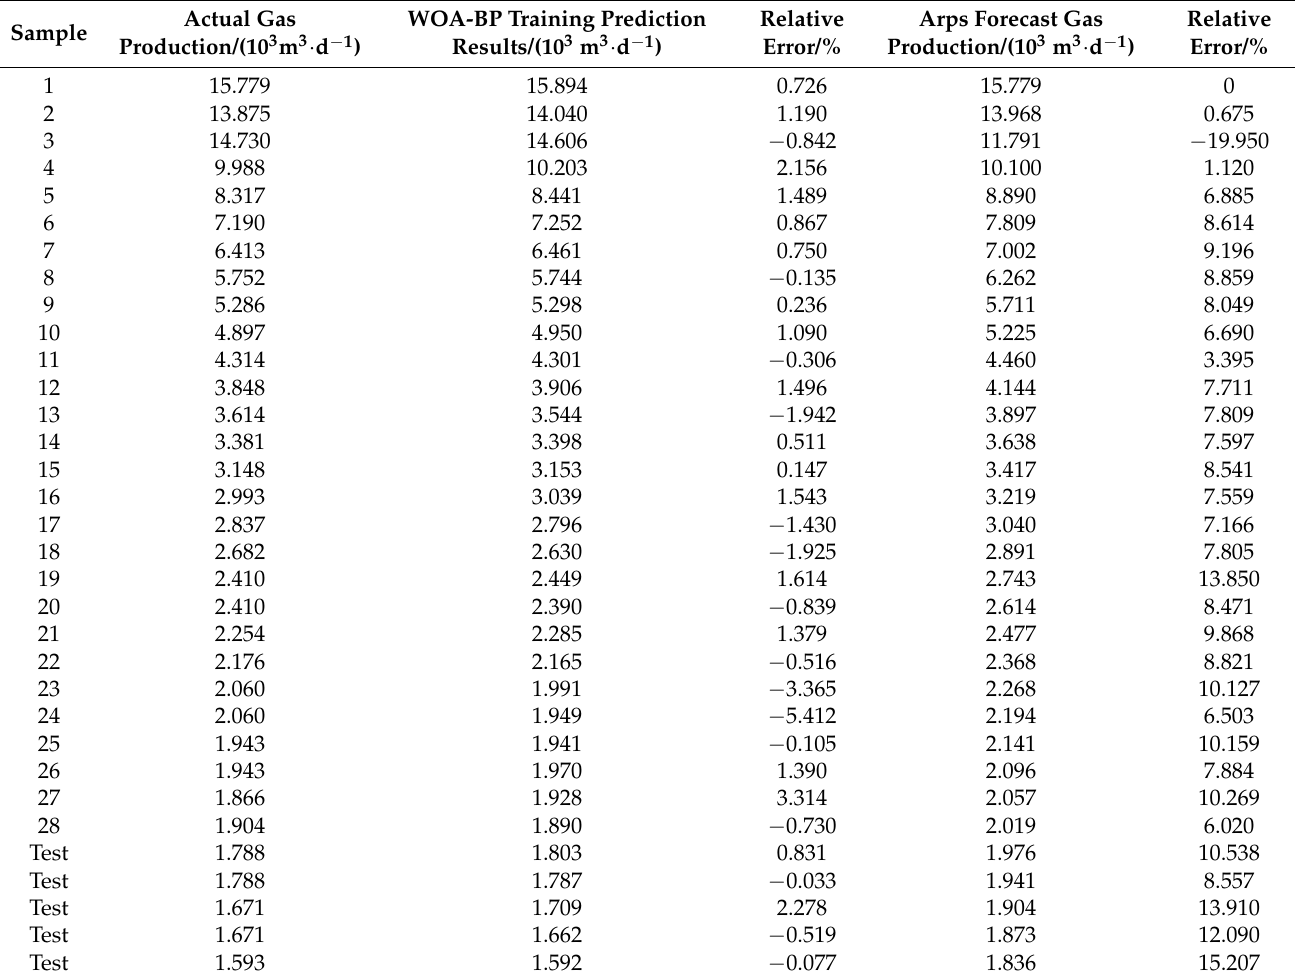
Table 3. Comparison of WOA-BPNN and Arps prediction results with actual